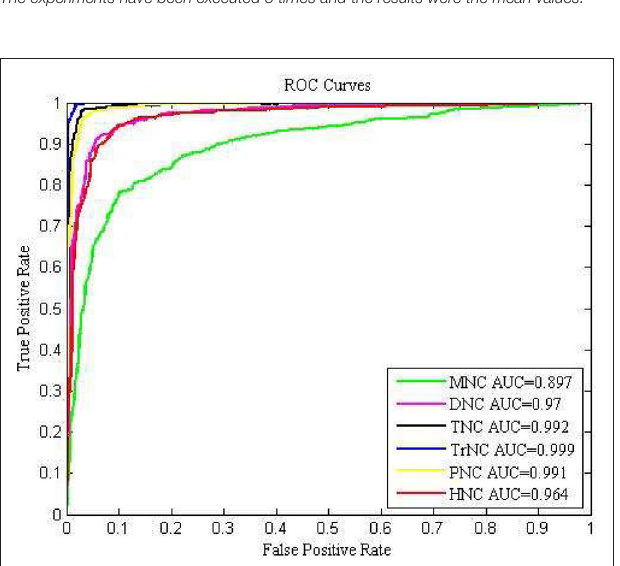
Frontiers in Microbiology |